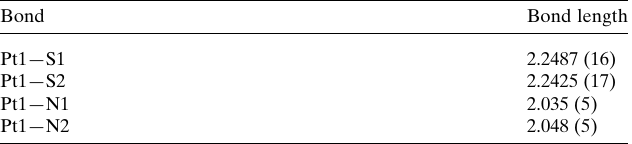
Table 1 Selected Pt—N and Pt—S bond lengths (A˚ ).